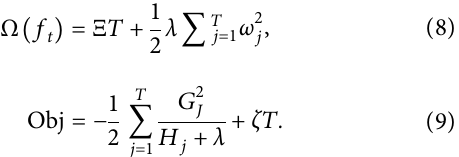
Figure 2: The prediction process of XGBoost algorithm in com- pany’s financial risk